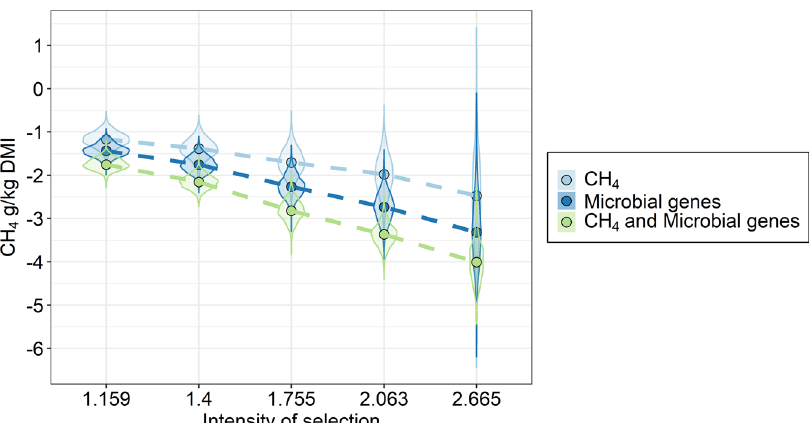
Fig. 8 Response to selection per generation on methane (CH 4 ) emissions estimated using direct genomic selection based on measured CH 4 emissions (light blue), indirect genomic selection based on 30 microbial gene abundances most informative for host genomic selection for CH 4 (dark blue) or selection on both criteria (green). Intensities of selection 1.1590, 1.400, 1.755, 2.063, or 2.665 are equivalent to selecting 30, 20, 10, 5, or 1%, respectively, of our n = 285 animal population with CH 4 and metagenomic data based on the above-described selection criteria. Dots display the medians and violin plots represent the estimated marginal posterior distributions of the response to selection for each intensity of selection and breeding strategy. Source data is in Supplementary Data